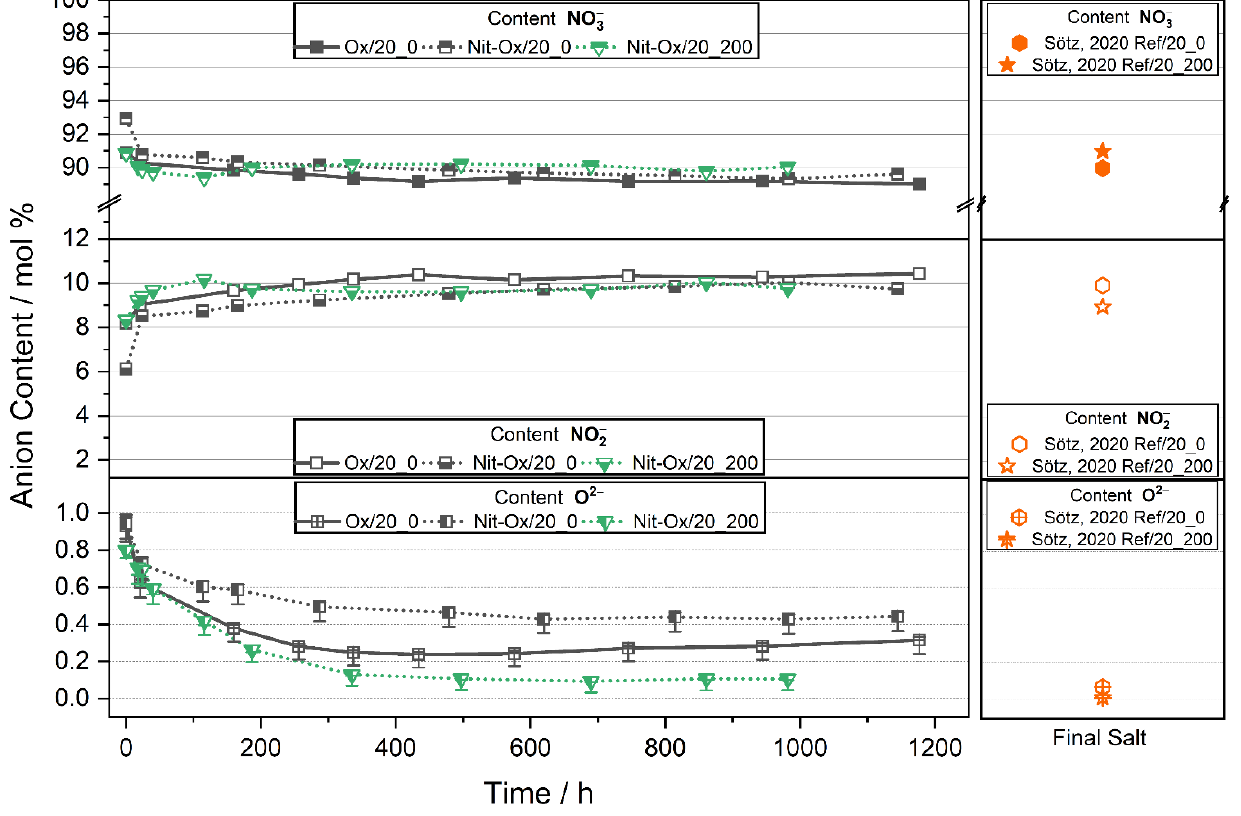
Figure 2. Content of nitrate, nitrite and oxide ions of investigated nitrate melts in this work with oxide addition. Literature data (orange symbols) shown (Ref/20_0, Ref/20_200) without oxide addition. All melts were stored under synthetic air with/without 200 ppm NO indicated by the label. Error bars not visible are within symbol size.